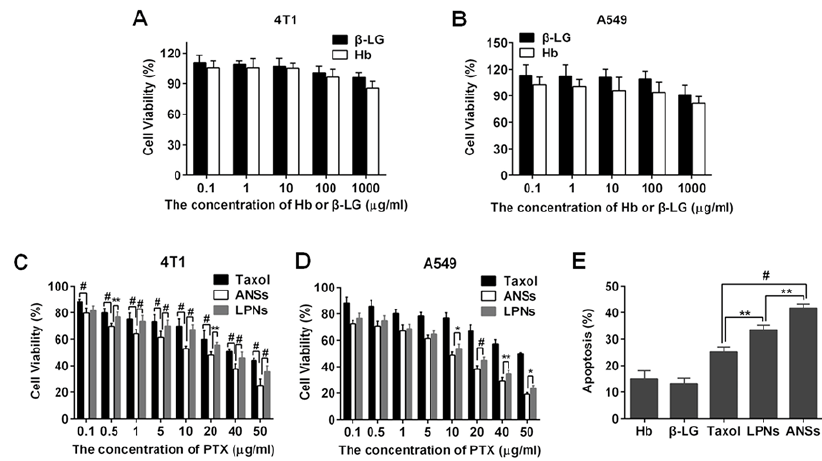
Figure 7. Cytotoxicity of Hb and β-LG from 0.1 to 1000 µg/mL in ( A ) 4T1 and ( B ) A549 cells. Comparison of the cytotoxicity between ANSs and LPNs with the dose of PTX from 0.1 to 50 µg/mL in ( C ) 4T1 and ( D ) A549 cells. The incubation time was 48 h. ( E ) Apoptosis rate determined by flow cytometry after 48 h incubation at a PTX concentration of 10 µg/mL at 37 °C ( n = 3, ** p < 0.01 and # p < 0.001).